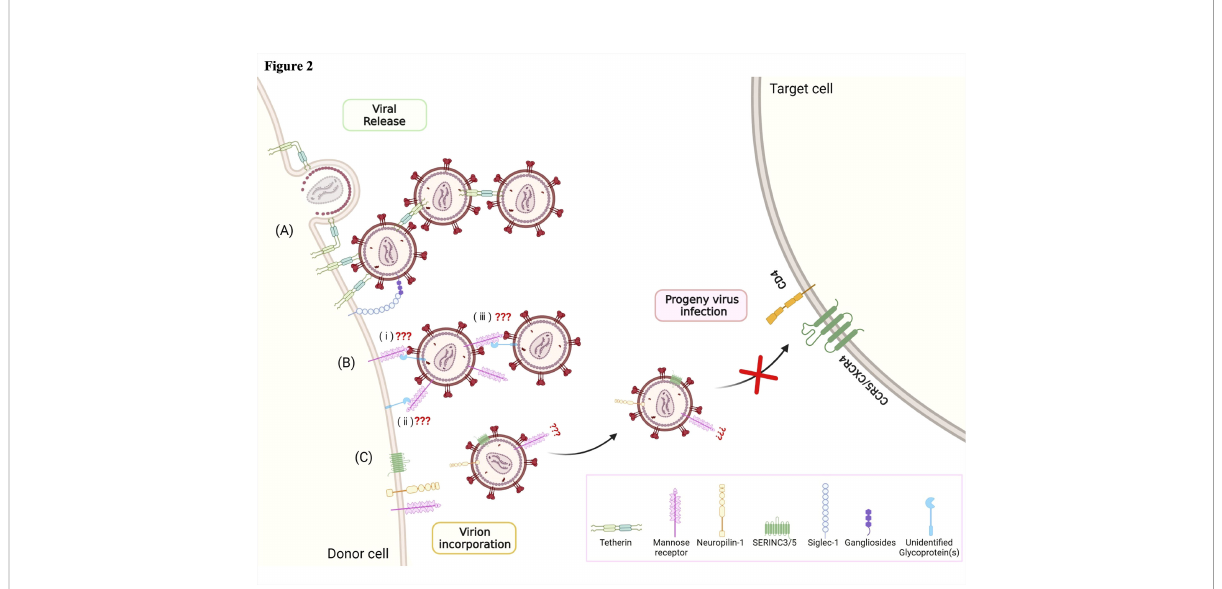
FIGURE 2 Host factors regulating the late phase of the HIV-1 life cycle, from viral release to progeny virus infection. Various cellular host factors including tetherin, mannose receptor (hMRC1), neuropilin-1 (NRP-1), SERINC3/5, and Siglec-1 are highly expressed on the surface of the plasma membrane. (A) Tetherin and Siglec-1 play a role in capturing viral particles at the budding step. (B) hMRC1 also inhibits viral particle release. It is hypothesized that (i) hMRC1 expressed on the cell surface may interact with Env glycoprotein and/or unidenti fi ed host glycoprotein(s) associated with viral particles. (ii) Unidenti fi ed host glycoprotein(s) expressed on the cell surface may interact with hMRC1 associated with viral particles. (iii) Viral particle-associated hMRC1 may interact with Env glycoprotein and/or unidenti fi ed host glycoprotein(s). However, the precise mechanisms are still unclear. (C) Virion-incorporated SERINC3/5 and NRP-1 contribute to the inhibition of progeny virus infection through interference with the binding step. Image created with